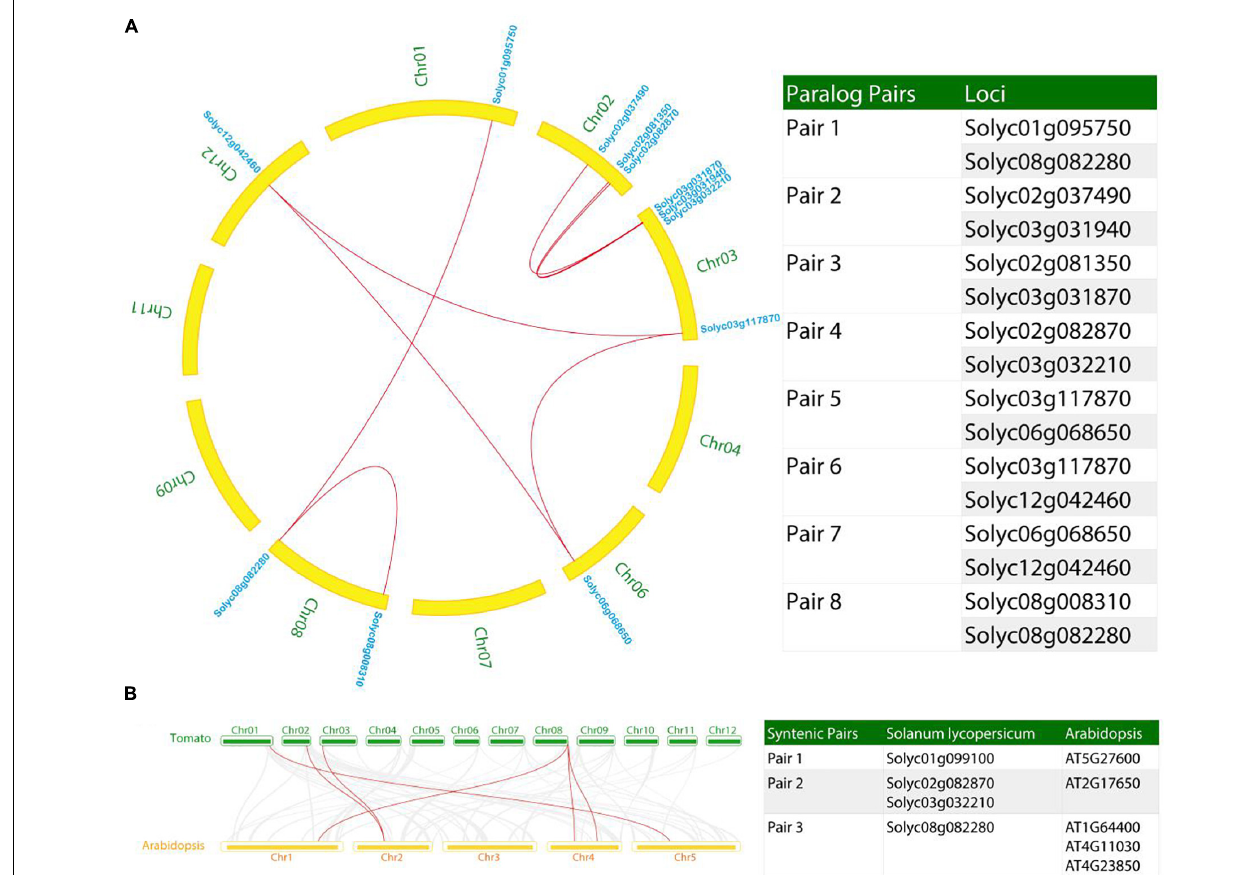
FIGURE 6 | Syntenic analysis of AAE genes in the tomato genome. (A) Identification of paralog pairs in syntenic blocks within the tomato genome. Ten paralog pairs were identified. (B) Synteny analysis of AAE genes between tomato and Arabidopsis . Three syntenic pairs were found in this analysis. Gray lines in the background indicate the collinear blocks within tomato and Arabidopsis , while the red lines highlight the syntenic AAE gene pairs.